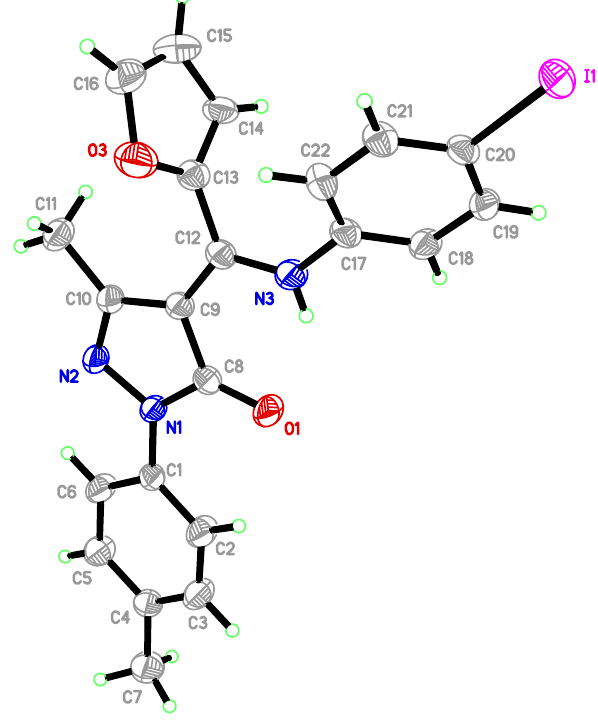
Table  : Data collection and